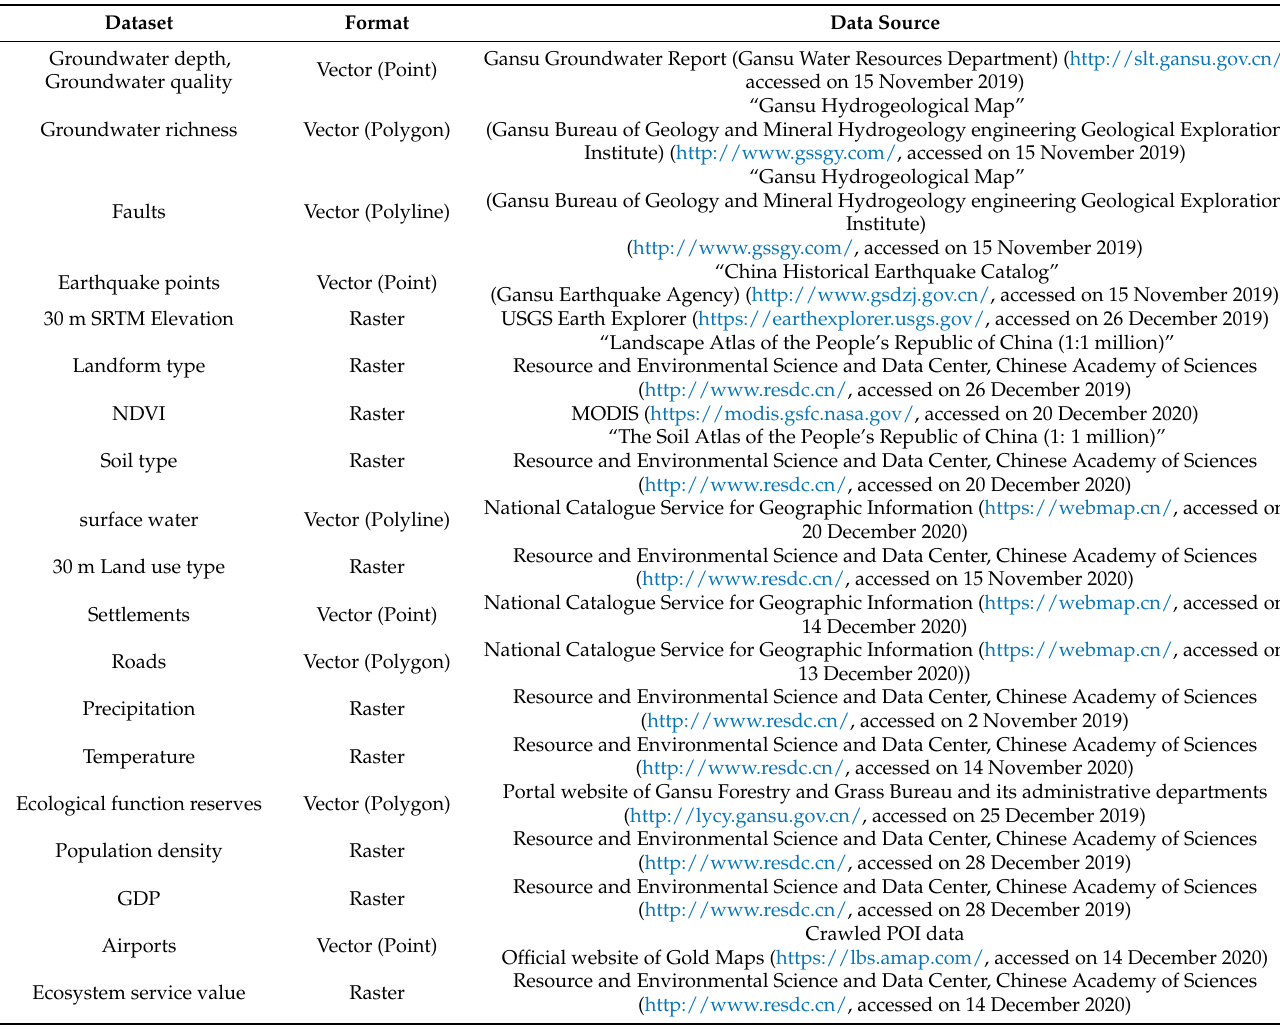
Table A1. Data Format and